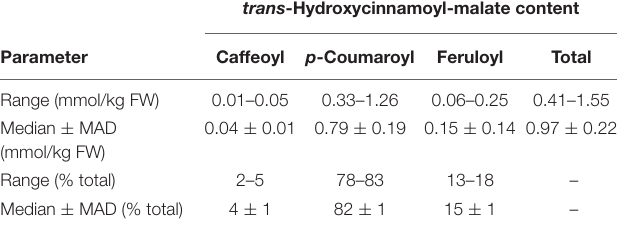
FIGURE 3 | Content of various hydroxycinnamoyl-malate esters in leaves of eight independent HMT alfalfa transformants. Center lines show the medians, box limits indicate the 25th and 75th percentiles as determined by R software, whiskers extend to the minimum and maximum values. TABLE 2 | Accumulation of hydroxycinnamoyl esters in leaves of eight independent HMT